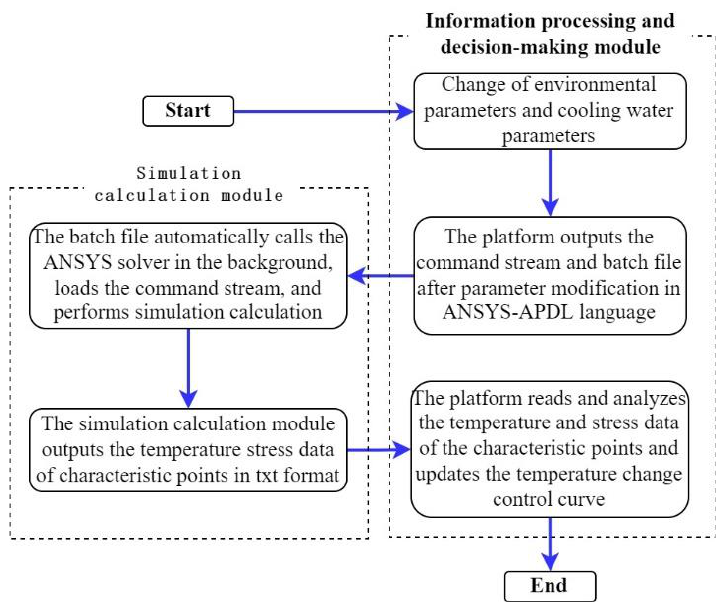
Figure 10. Sketch of the information interaction.